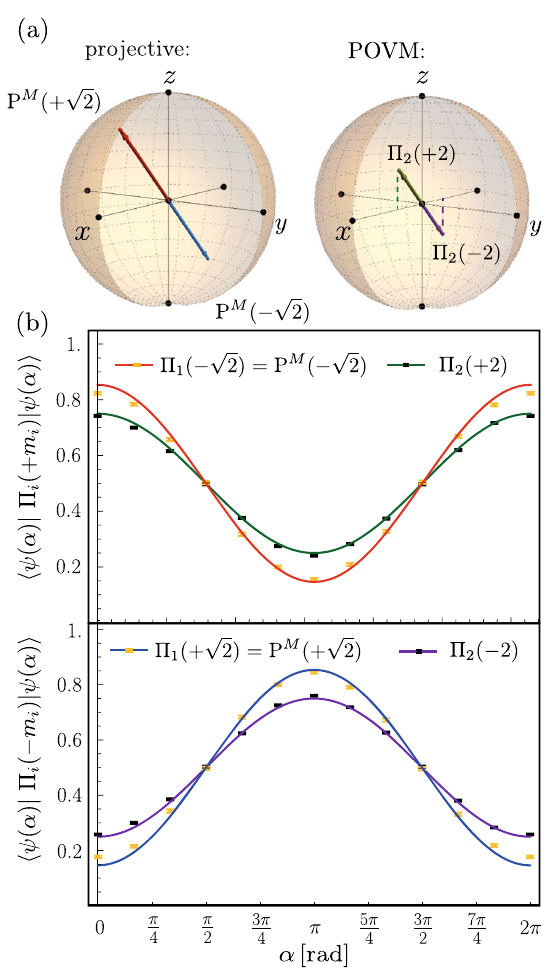
Fig. 3 Experimental results of projective (sharp) measurement Π 1 and generalized (unsharp) measurement Π 2 . a Bloch sphere ffiffiffi ffiffiffi p p 2 2 depiction of projectors Π 1 ð ± Þ ¼ P M ð ± Þ of sharp, and POVM elements Π 2 ( ± 2) of unsharp measurement. b Expectations values of ffiffiffi ffiffiffi p p ψ ð α Þh j Π 2 2 Þ ψ ð α Þj i ¼ ψ ð α Þh j P M ð ± Þ ψ ð α Þj i for projective and 1 ð ± ψ ð α Þj i for generalized POVM in state ψ ð α Þj i with ψ ð α Þh j Π 2 ð ±2 Þ measurement time t meas = 100 s. (error-bars represent ±1 st. dev.).